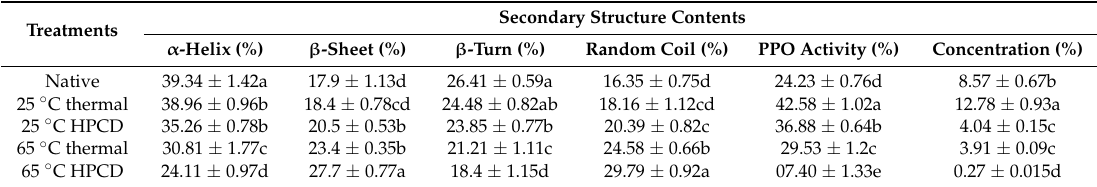
Table 2. Secondary structure contents of thermal- and HPCD-treated PPO.